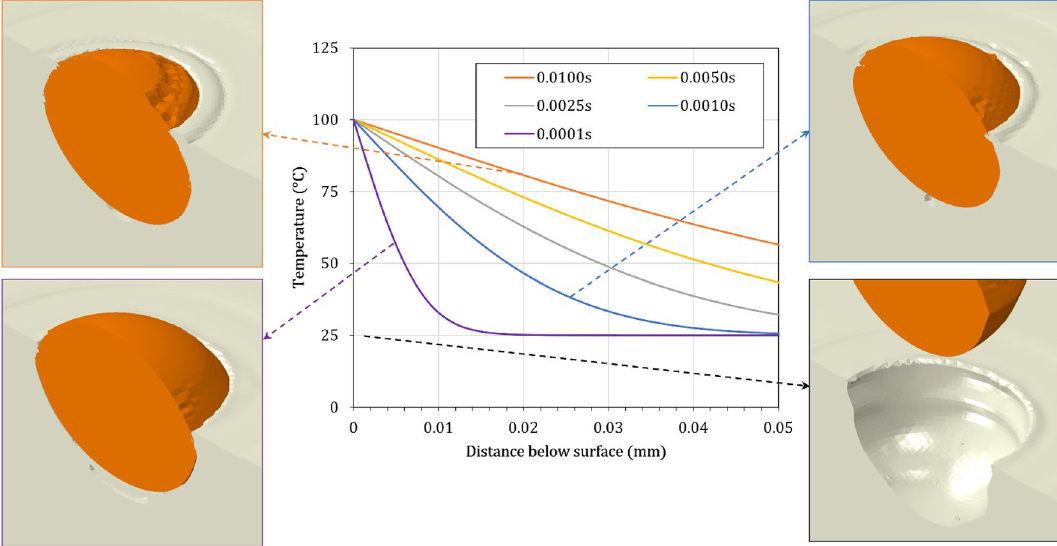
Figure 10. The effect of substrate temperature gradient on particle bonding at V p = 500 m / s at a sufficiently prolonged time. Times listed in the legend of the diagram, indicate the time that particle arrives at the substrate during